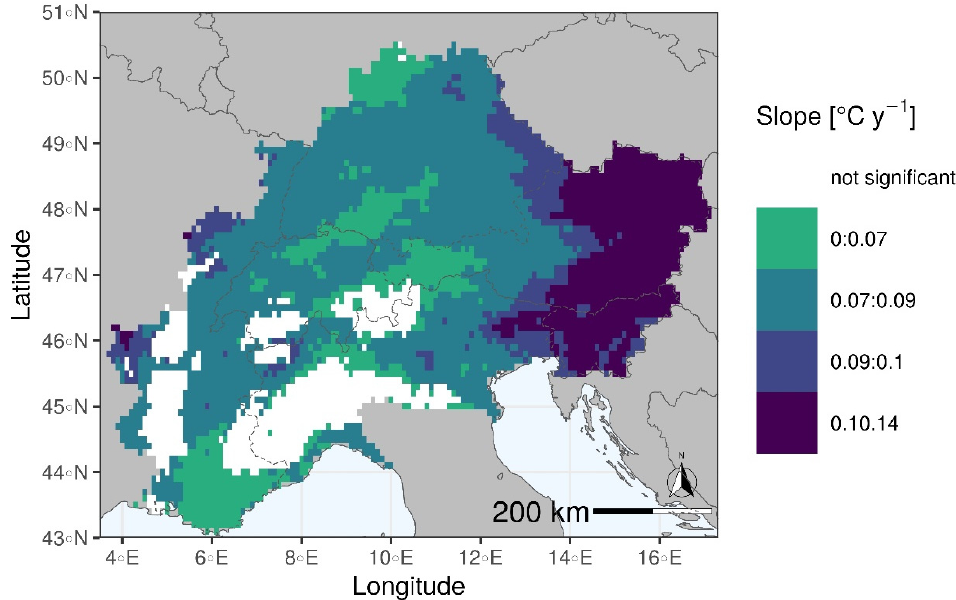
Figure 10. Sen’s slope of the trend at 5% significance level for yearly air temperature, Ta , based on yearly average from March to October, from 2003 to 2019. For both MOD16 and SSEBop, there was widespread spatial overlapping between Ta and ET trends, and data were clustered in two sets, one with positive trends, over most of the areas with positive ET trends (>70%), the other with positive Ta trends and negative ET trends, over most of the area with negative ET trends (>84%) (Table 6). However, the correlation was very low (Supplementary Figure S39–S40).